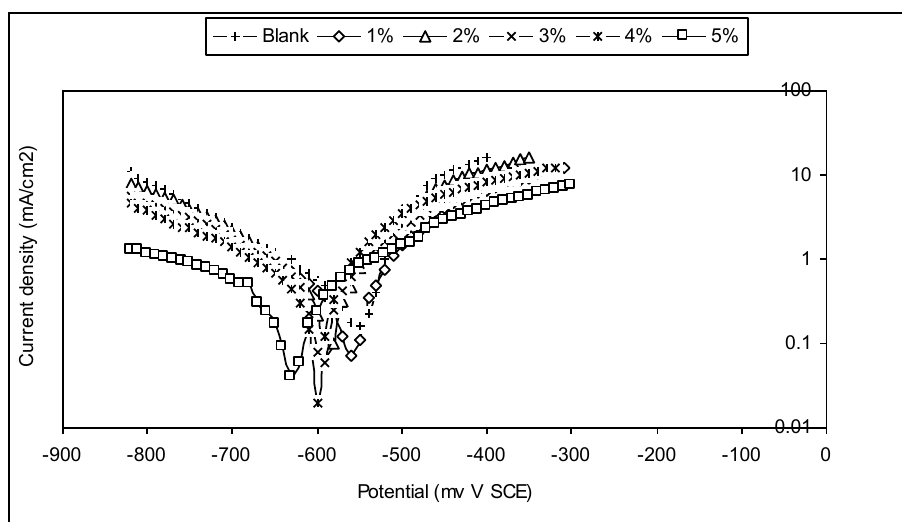
Figure 6. Typical Potentiostatic curves for mild steel in 2N Phosphoric acid with